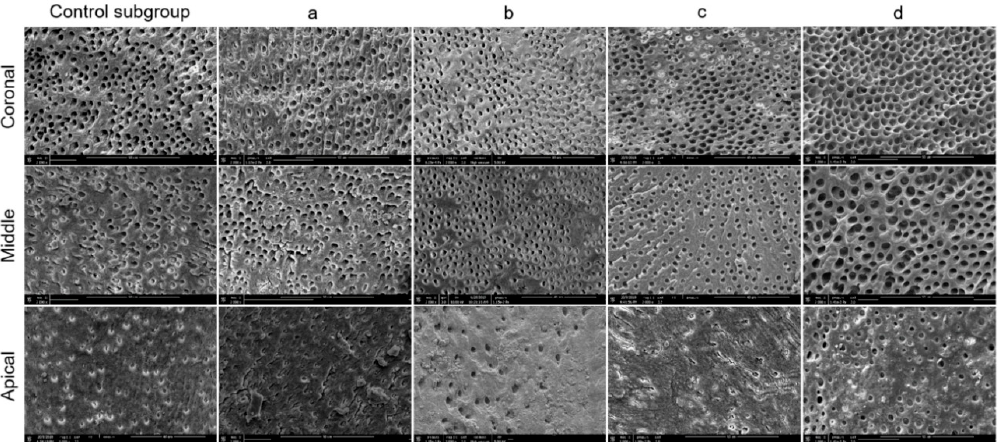
Figure 5. Representative scanning electron microscopy micrographs ( × 2000 magnification) of the coronal, middle, and apical thirds in samples from G2 (with pre-endodontic restoration). Five subgroups studied: (Control subgroup) Syringe and needles; ( a ) Endoactivator; ( b ) EQ-S; ( c ) XP-Endo finisher; ( d ) EndoUltra cordless.